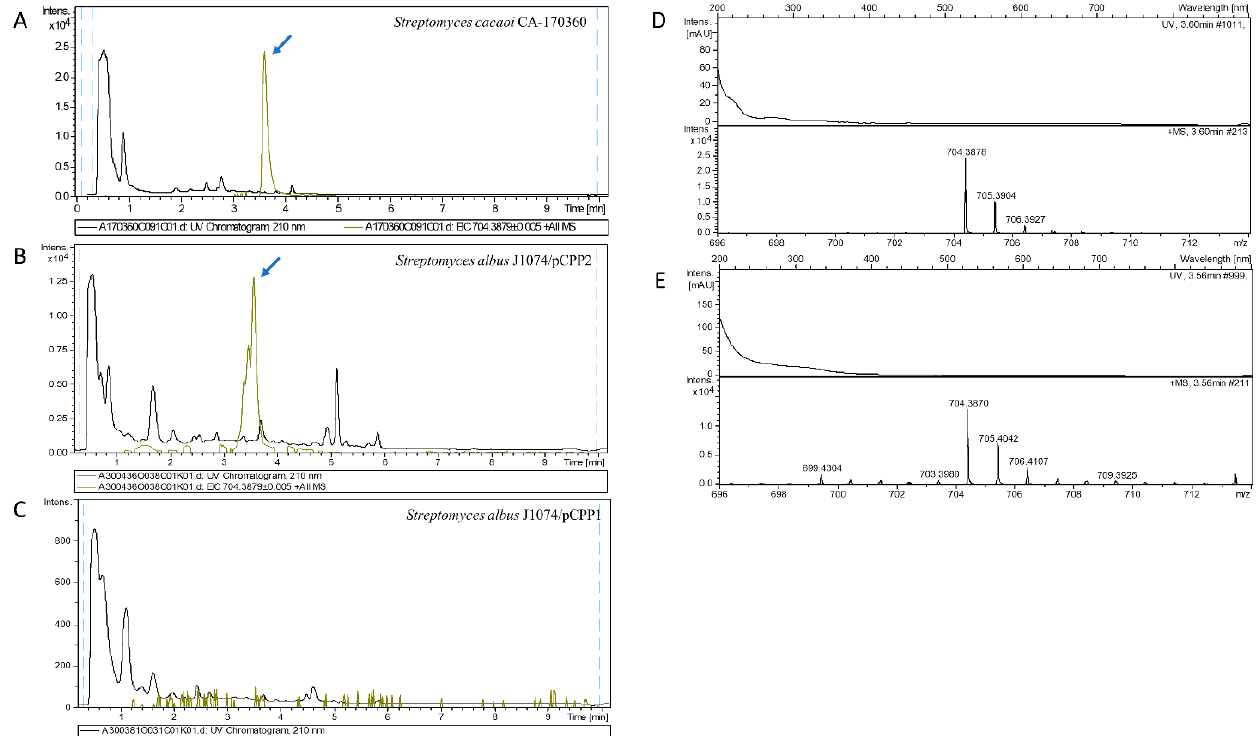
Figure 7. Pentaminomycin D production. Left. Chromatograms of UV absorbance at 210 nm and extracted ion m/z = 704.3879 ± 0.005, C 36 H 50 N 9 O 6+ of pentaminomycin D (blue arrow) from original producing strain Streptomyces cacaoi CA- 170360 ( A ) and the heterologous producing strains Streptomyces albus J1074/pCPP2 ( B ) and Streptomyces albus J1074/pCPP1 ( C ). Right. Experimental UV and positive mass spectra from C 36 H 50 N 9 O 6+ (calculated value: 704.3879) adduct from original producing strain Streptomyces cacaoi CA-170360 ( D ) and the heterologous producing strain Streptomyces albus J1074/pCPP2 ( E ). No UV or mass spectra were obtained with the heterologous producing strain Streptomyces albus J1074/pCPP1 as it did not carry the NRPS gene required for the production of pentaminomycins. The chromatograms showing the production of the rest of pentaminomycins are depicted in Figures S3–S5.